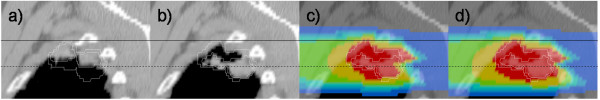
ITV optimization. The effect of optimization to an ITV incorporating 4DCT information. Reference 4DCT phase at end-exhalation (a) and end-inhalation (b) with GTV and ITV contours in white. c) If treatment plan optimization to the ITV is based on the reference 4DCT phase only, dose coverage of GTVinhale can not be guaranteed. d) GTVinhale coverage is achieved by including range information of all 4DCT phases into the optimization of the ITV based treatment plan. The dose distributions in c) and d) are calculated for a stationary target and end-inhalation.